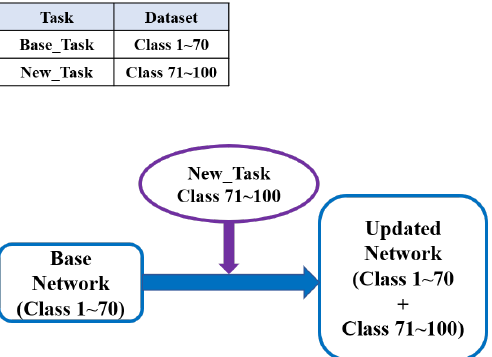
Figure 2. Incremental learning model: the network needs to accommodate its capacity by updating it with sequential new classes.